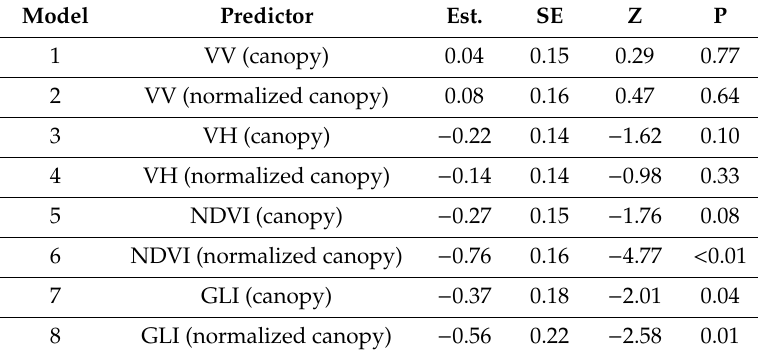
Table 2. Detecting leaf senescence and loss in Moabi crowns at Lop é NP, Gabon using satellite data. Model estimates are derived from eight single variate generalized linear mixed models (binomial) for the probability of detecting leaf senescence and loss events from focal canopy time series (mean value of all pixels within canopy) and normalized canopy time series (di ff erence between the mean value of all pixels within the canopy and the mean value of all pixels in the surrounding forest bu ff er) of the VV and VH bands of the Sentinel-1 synthetic aperture radar (SAR) data and the normalized di ff erence vegetation index (NDVI) and the green leaf index (GLI) derived from Sentinel-2 optical data. Mixed models included tree ID and year as random e ff